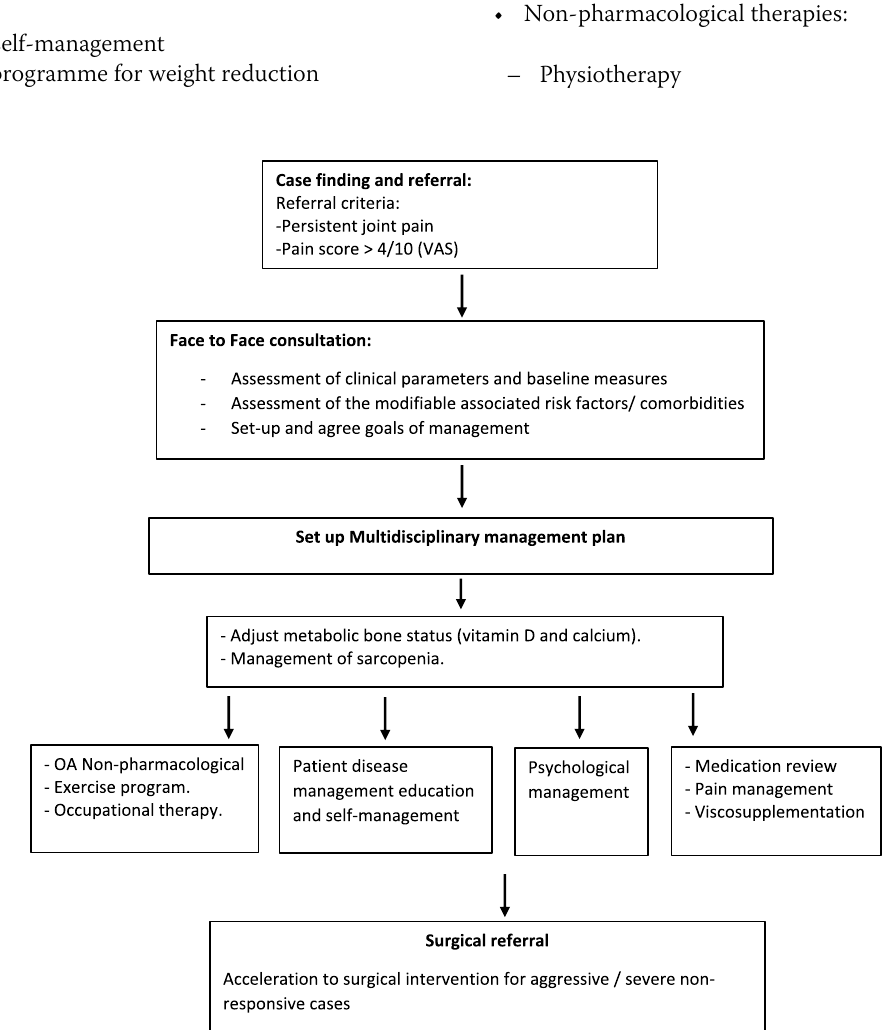
Fig. 1 Multifaceted approach to the assessment and management of OA